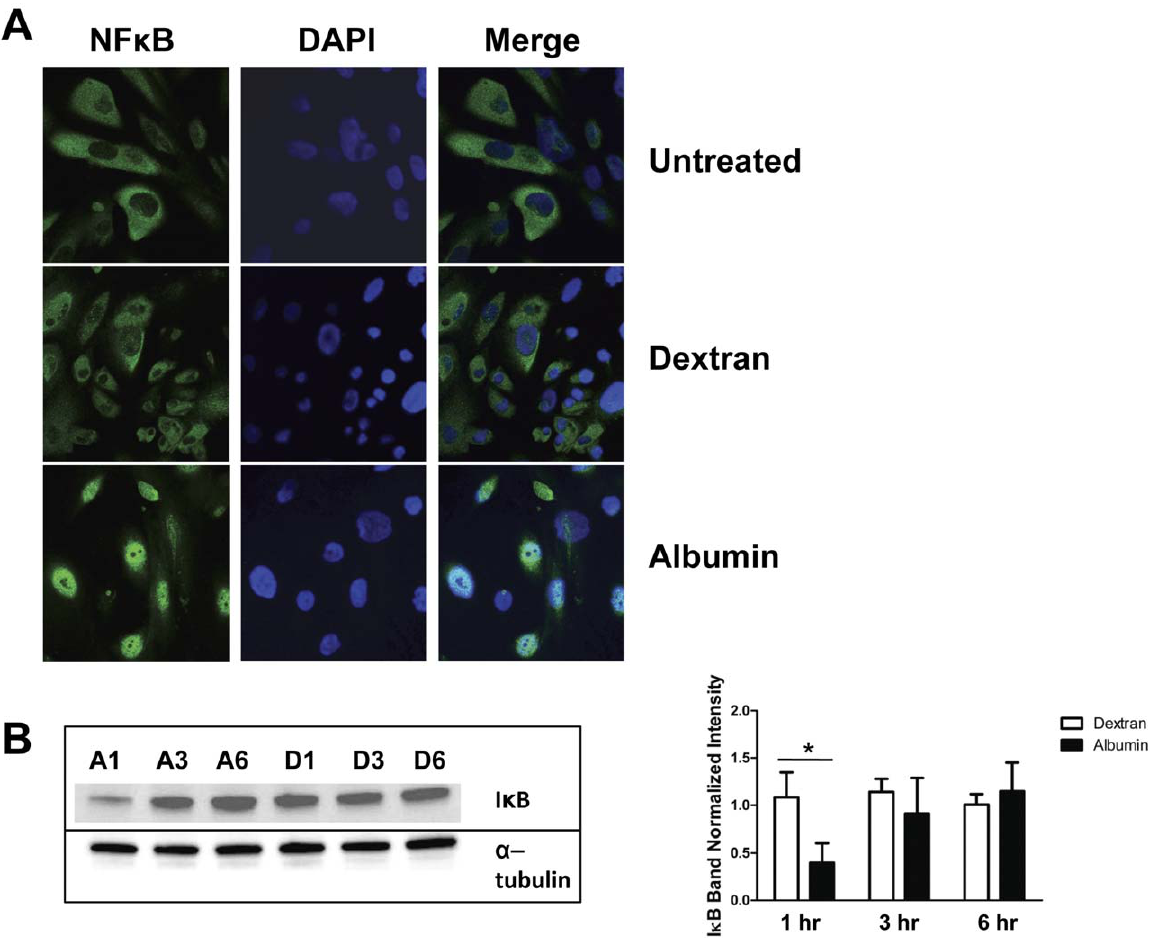
Figure 5. Albumin exposure activates NF k B. A , Confocal images of cultured human podocytes without treatment (top panel), and treated with 5 mg/ml dextran (middle panel) or 5 mg/ml recombinant human albumin (bottom panel) for 8 hrs. Cells were stained with an antibody against NF k B and with DAPI for nuclear localization. Albumin treatment, but not dextran treatment, was associated with translocation of NF k B to the cell nucleus. B , Albumin exposure leads to I k B degradation in podocytes. Western blot of lysate from podocytes treated with 5 mg/ml recombinant human albumin (A) or dextran (D) for 1 hr, 3 hrs or 6 hrs and probed with an antibody to I k B. Albumin treatment causes an initial degradation of I k B which is required for NF k B activation. a -tubulin is shown as a loading control. Graph to the right of the Western shows densitometric quantitation of the I k B band normalized to a -tubulin. * denotes P=0.03 compared to dextran treated control cells.